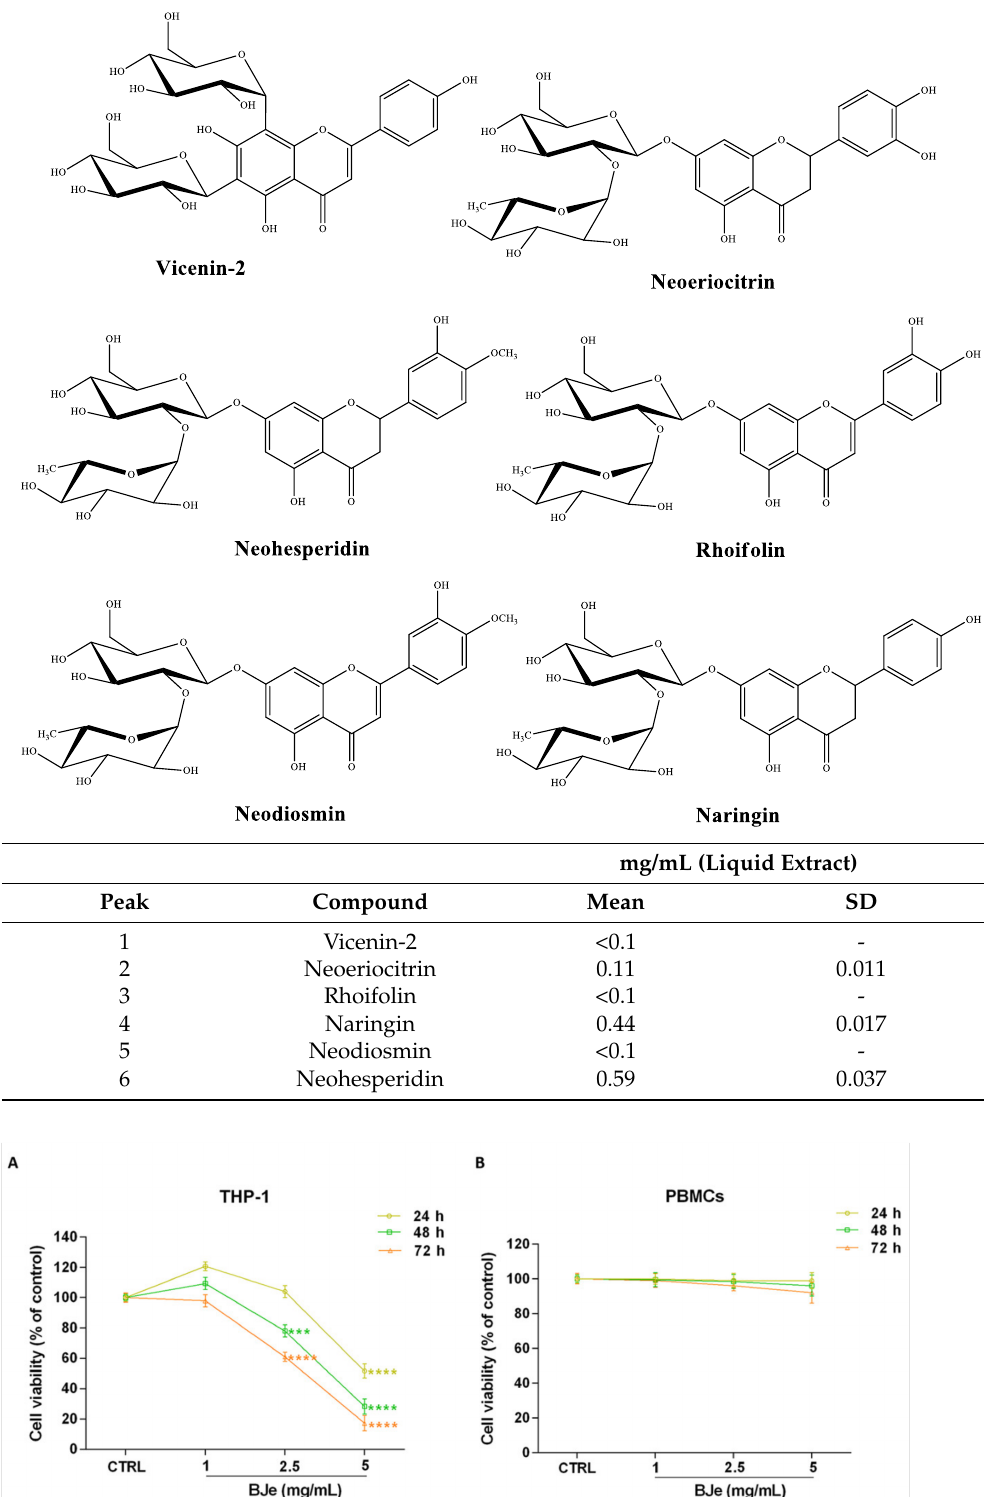
Table 2. Quantitative determination of the flavonoids identified in BJe and their chemical structures.